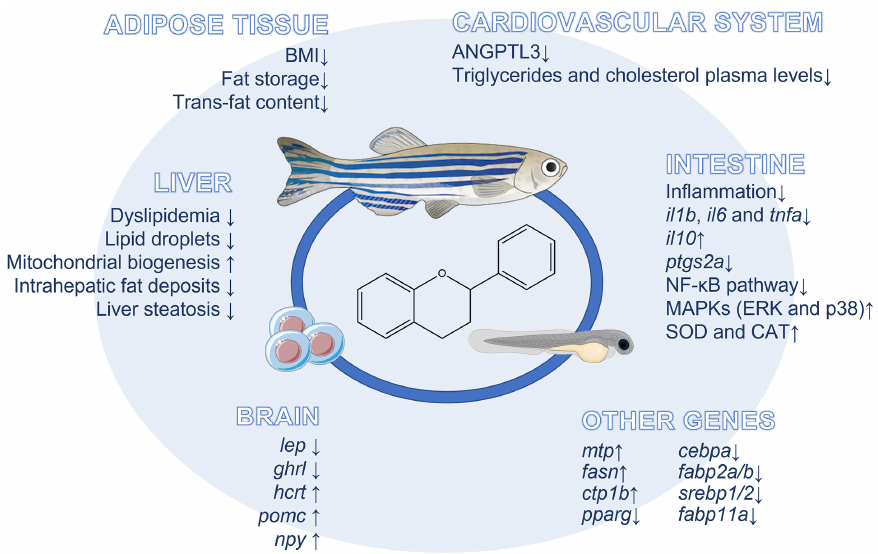
Figure 2. Mechanisms underlying the anti ‐ obesity effects of flavonoids in the zebrafish model.